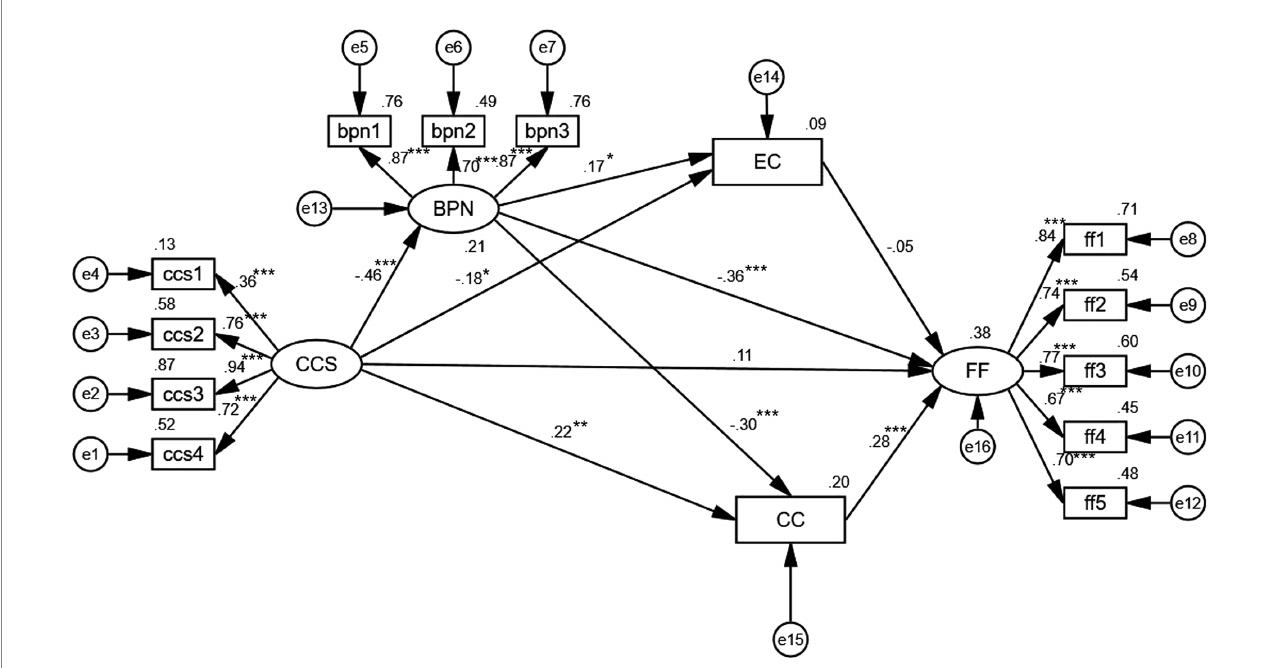
FIGURE 2 Path coefficient plot for the model. CCS, controlling coaching style; BPN, basic psychological need; CC, constrained commitment; EC, enthusiastic commitment; FF, fear of failure.